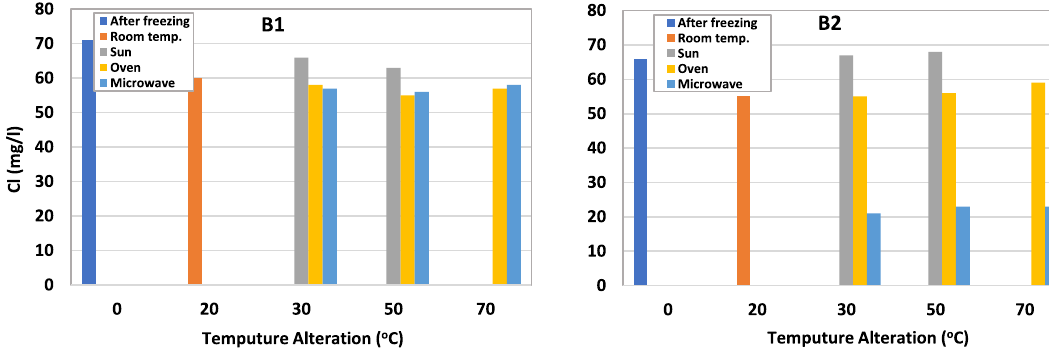
Fig. 5 Chloride concentrations at different heating degrees for brands B1 and B2